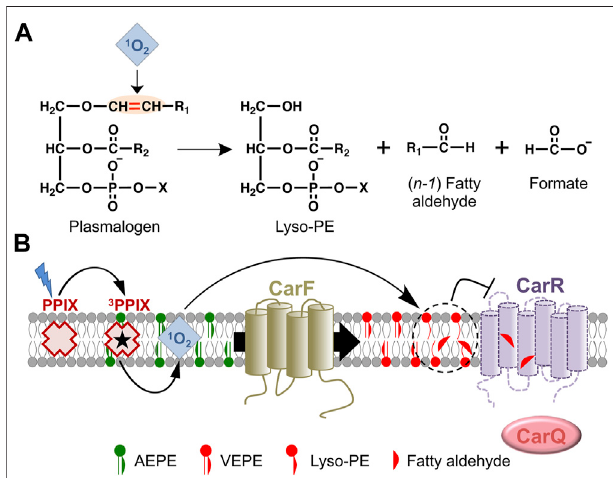
FIGURE 7 | Plasmalogen signaling in the M. xanthus response to photooxidative stress. (A) Cleavage by 1 O 2 of the plasmalogen vinyl ether bond and its products. (B) Model for the plasmalogen-based signal transduction pathway leading to CarR inactivation in M. xanthus (arrows for activation; blunt ended for inactivation). As the PEDS1 desaturase, CarF converts (both in the dark and in the light) the plasmanyl precursor (AEPE) to plasmalogen (VEPE),whichisabsolutelyrequiredintheresponse toblue light. Generationof 1 O 2 uponphotoexcitationofPPIXprovokescleavageofVEPEat the vinyl ether bond, generating a fatty aldehyde and lyso-PE. This may inactivateCarRdirectlybyadductformationwiththereactive fatty aldehyde or by lipid remodeling and perturbation of the local membrane structure around CarR, leading to a conformational change and/or degradation of CarR. As a consequence, CarQ is liberated, associates with RNA polymerase (RNAP), and activates speci fi c genes leading to carotenoid synthesis.